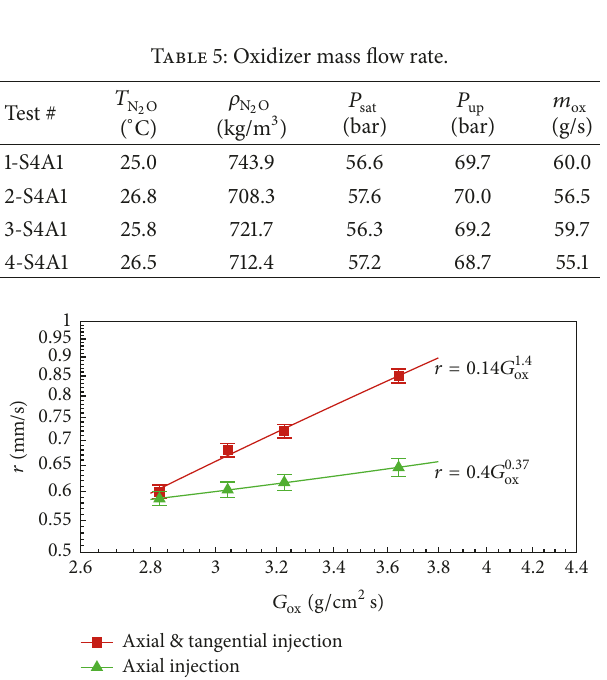
Figure 10: Fuel regression rate versus oxidizer mass